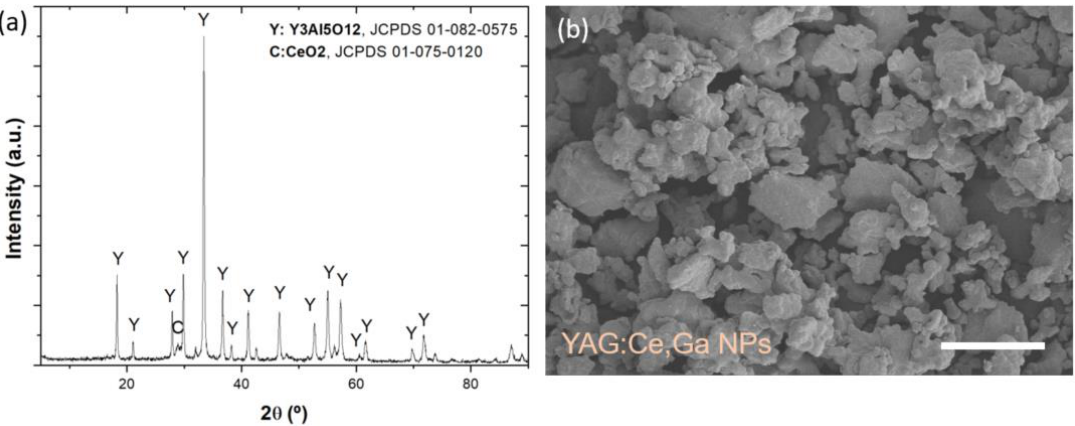
Figure 3. ( a ) XRD pattern of the YAG:Ce,Ga powder calcined at 1100 °C. ( b ) SEM image of the calcined YAG:Ce,Ga powder. Scale bar: 20 µm.